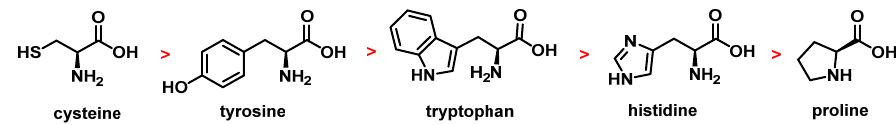
Figure 33. Reactivity of cysteine, tyrosine, tryptophan histidine, and proline with ClO 2 .